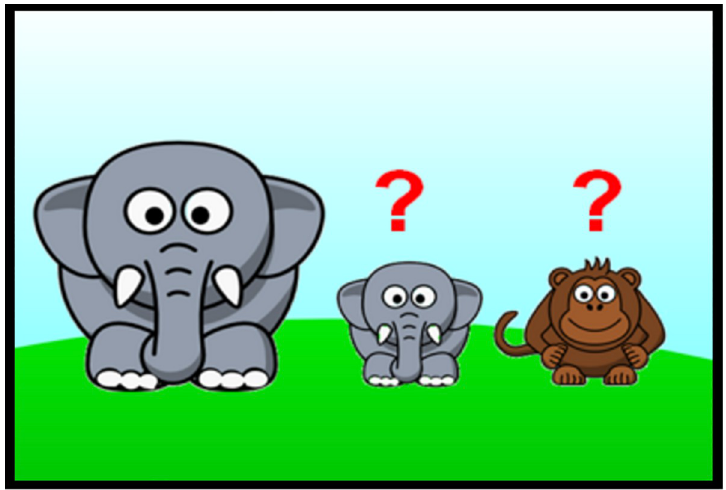
Fig 2. Graphical display of response probe for the c-MDT. Small elephant and monkey represent ‘same’ and ‘different’ response choices, respectively. Image is presented in full colour within the actual